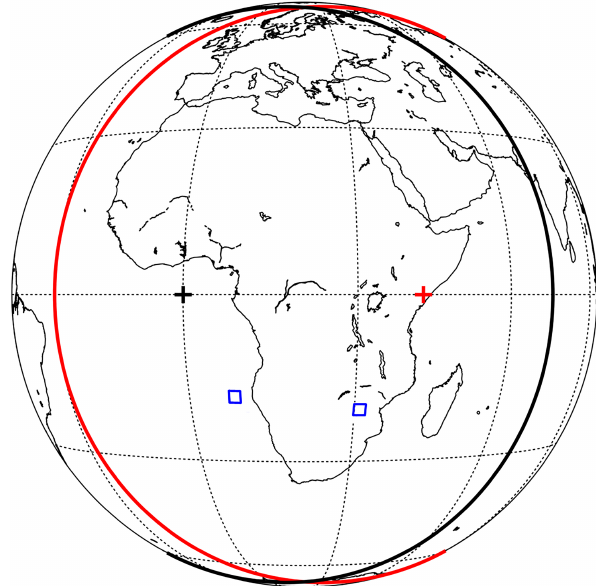
Figure 1. The overlap area created by the disks of MSG-1 (red line) and MSG-3 (black line). The red and black crosses show the corre- sponding nominal sub-satellite points. The blue rectangles show the study regions west of the African coast (16.5–18.5 ◦ S, 7.5–9.5 ◦ E) and in the southern parts of Zimbabwe and Mozambique (19–21 ◦ S, 30–32 ◦